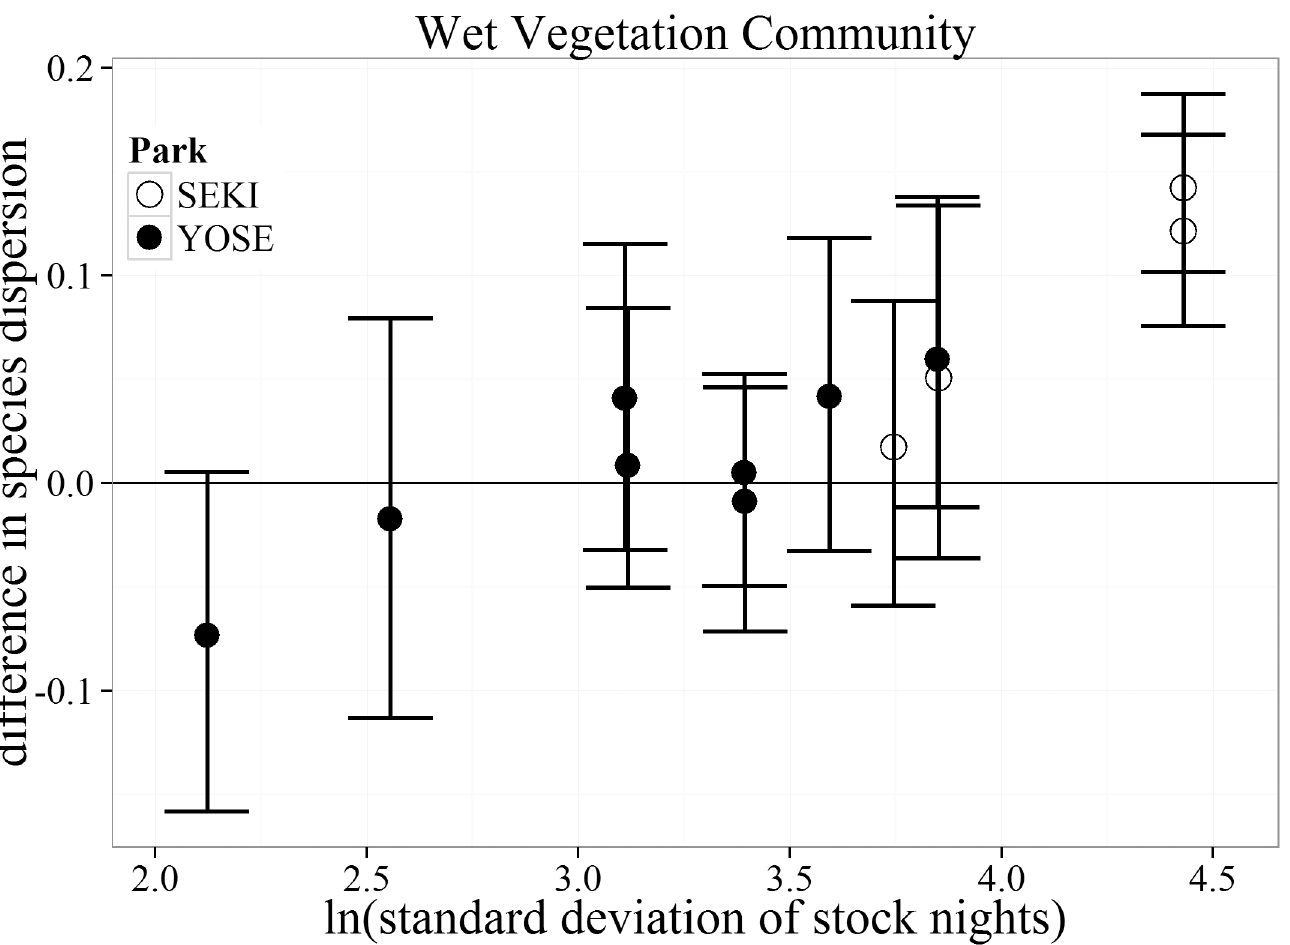
Fig 6. Bootstrapped mean (with 95% confidence intervals) differences in species dispersion for the Wet vegetation community type between matched meadows (N = 12) in Yosemite (YOSE) and Sequoia (SEKI) National Parks. The range of 1.4–4.9 (ln) standard deviationof stock nights corresponds to a range of 4–135untransformed stock